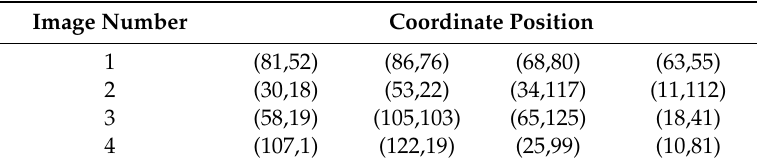
Table 1. Initial contour coordinate point of level set evolution.